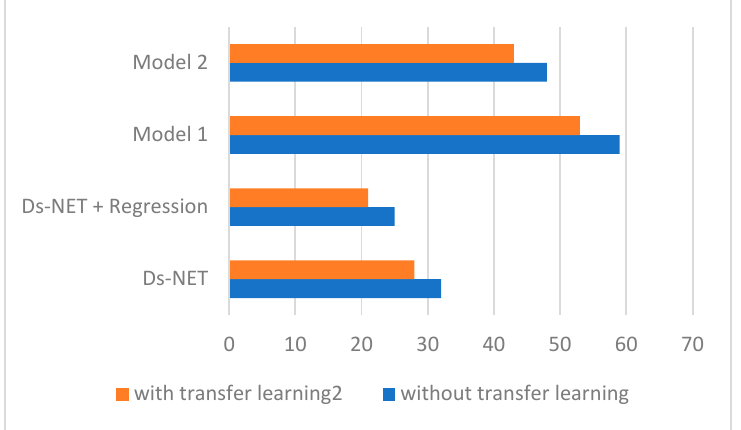
Figure 11. Prediction time of the Dns-Net model with regression inferring the transfer learning effect versus other models .